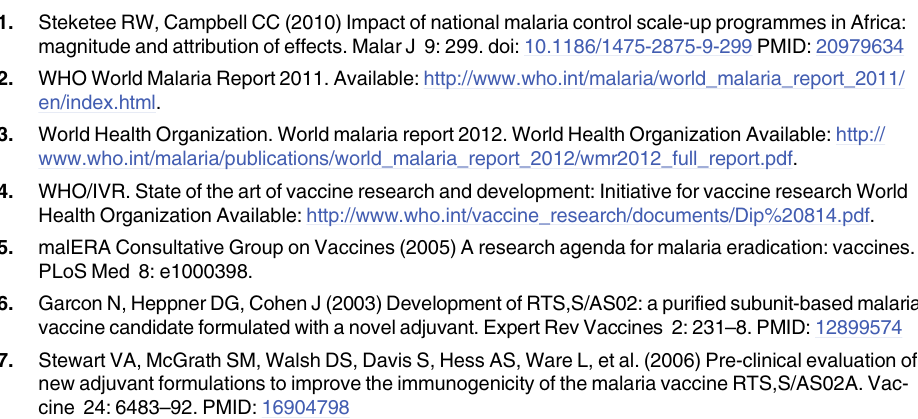
S1 Table. Unsolicited symptoms following dose 1. S2 Table. Frequency of CS-specific CD8+ T-cells expressing at least 2 cytokines/activation markers between IL- 2, IFN- γ , TNF- α and CD40L, per million PBMC (ATP cohort for